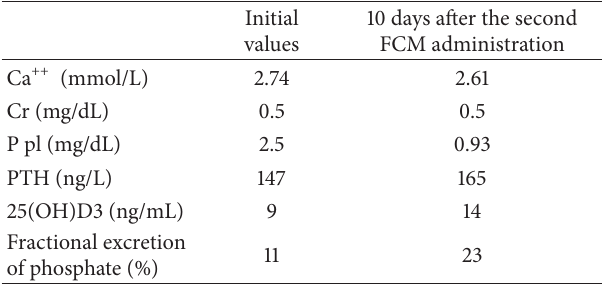
Table 1: Evolution of laboratory results.